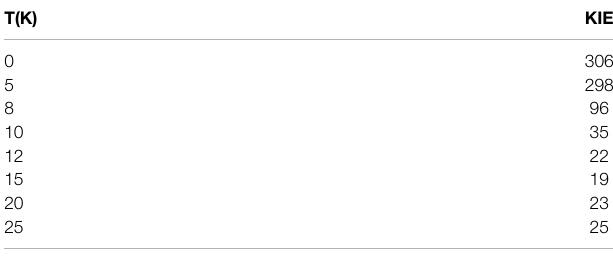
TABLE 3 | KIE for a symmetric double well with a weak coupling to its environment.Thepotentialparametersarethesameasfortheisolateddouble well. A Boltzmann weighting was performed assuming two energy levels, one at the energetic middle of the lowest pair of eigenstates of the isolated double well and one at the middle of the second lowest pair of states (with equal populations within each of the pairs).